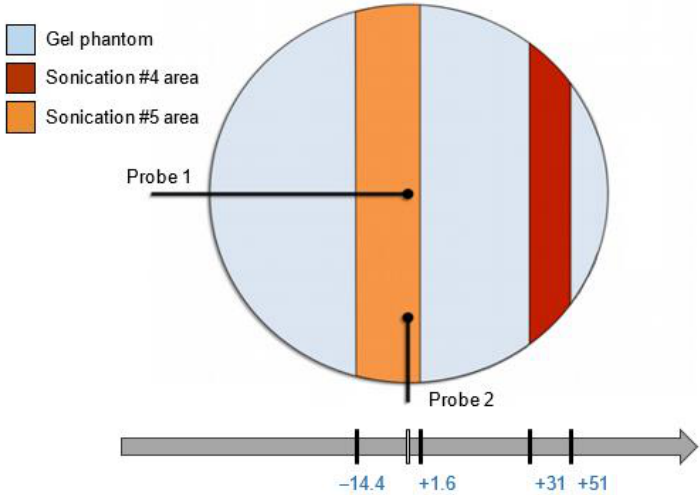
Figure 4. The MRI acquisition locations of sonications #4 and #5.